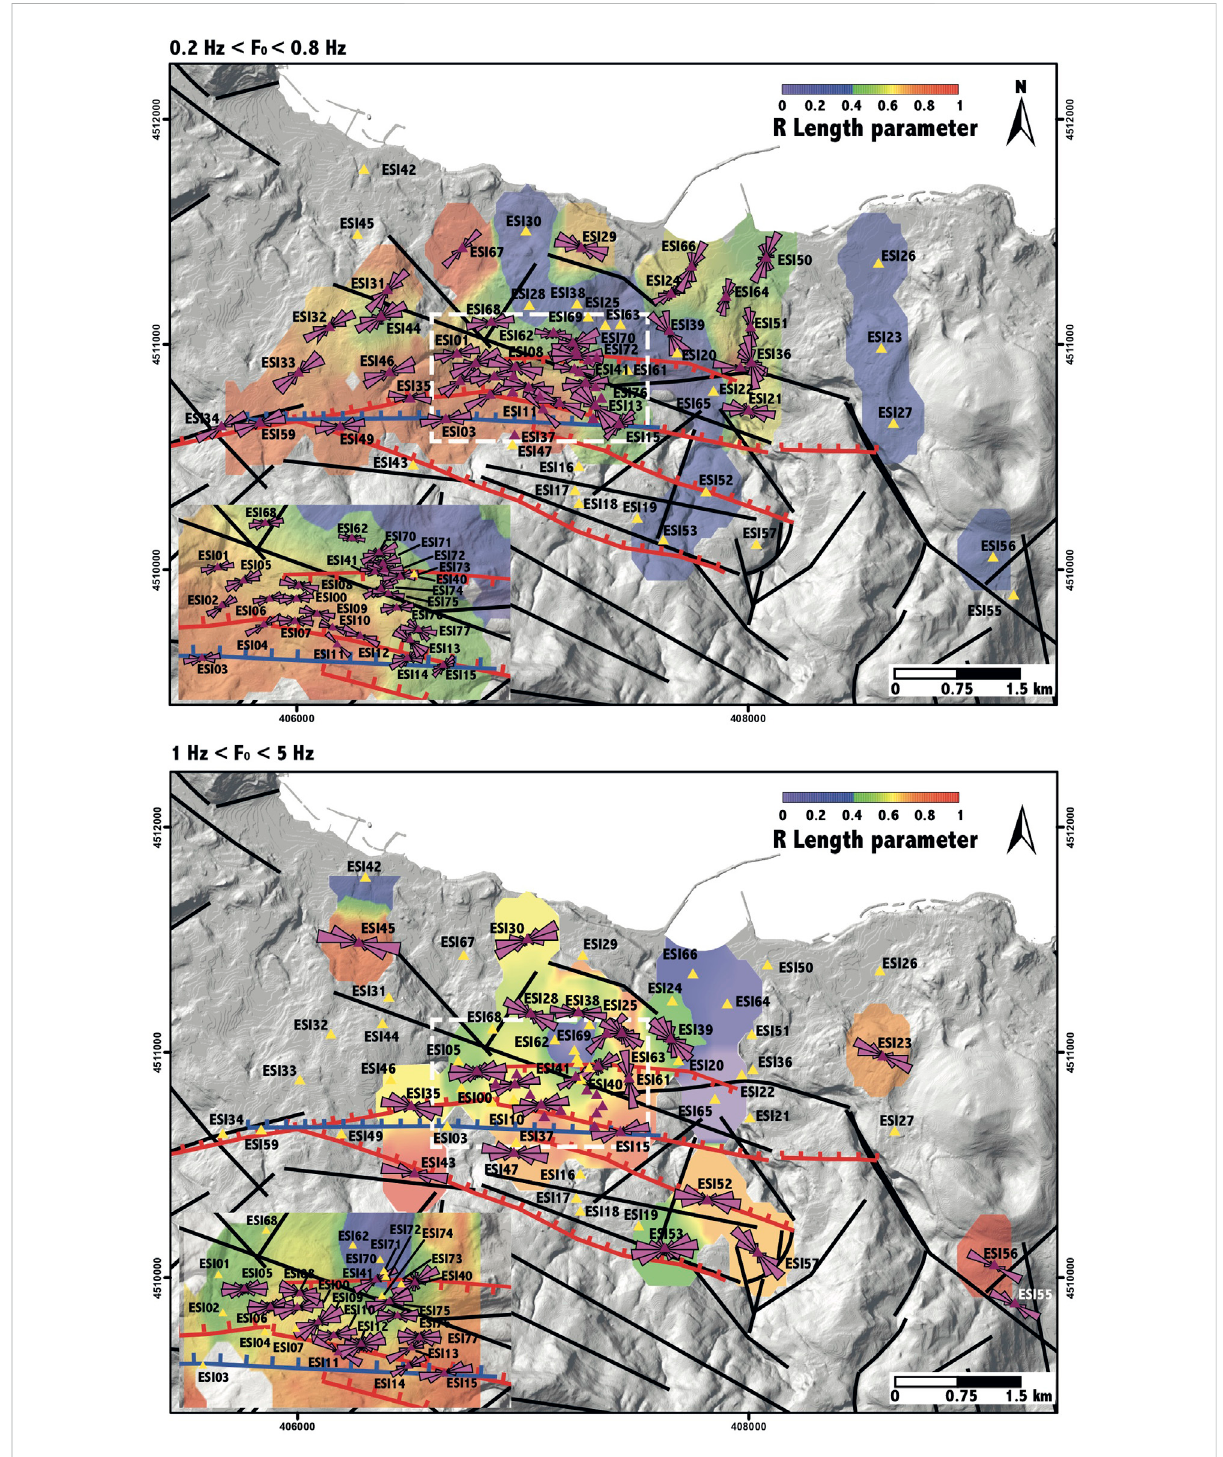
FIGURE 5 Results obtained in the two frequency bands, 0.2 – 0.8 Hz (top panel) and 1 – 5 Hz (bottom panel), through the covariance matrix analysis. The inset in the left-bottom is focused on Casamicciola village. Faults in the area are reported (red lines), as is the causative fault of the 2017 earthquake (blue line). Stations with directional ampli fi cation and polarization effects are depicted through red triangles, and the others, with yellow triangles. Polarization azimuth distribution is plotted as a rose diagram. Contour maps of the resultant length are produced using an inverse distance squared interpolation (red colors correspond to linearly polarized